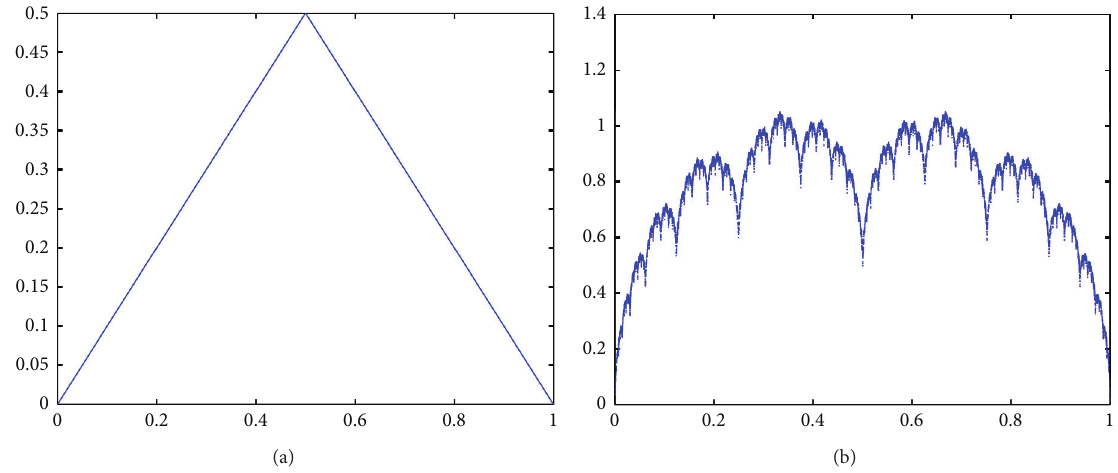
Figure 2: The graph of 𝜑(𝑥) in Example 8 and the graph of 𝜑 𝛼 (𝑥) with 𝜆 = 0.55